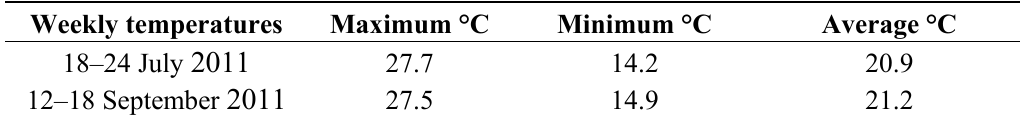
Table 3. Temperature values during the weeks